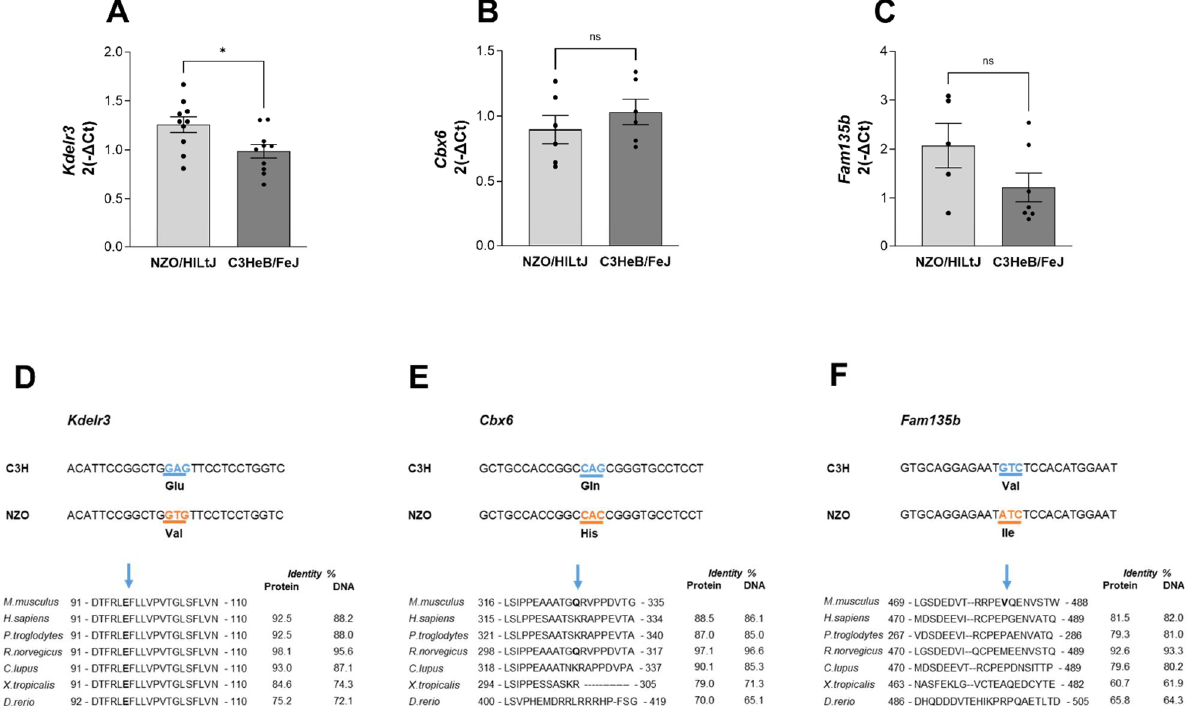
Figure 5. Combined approaches successfully identified potential causative genes underlying the Nbg15dis sublocus . Identification of C3H polymorphic regions underlying the Nbg15 sub-loci ( A ), variant effect prediction analysis (VEP) of identified non-IBD SNPs ( B ) and heatmap of islet specific genes containing non-IBD SNPs predicted to affect protein effectiveness selected via the VEP anal- ysis and the SIFT code under 0.5. Polymorphic regions were calculated using Genome Reference Consortium Mouse Build 38 provided by the Wellcome Trust Sanger Institute and defined as more than 50 SNPs/150 Kb window (gray boxes in ( A )). Red arrows ( A ) indicate the QTL peak markers of each Nbg15 sub-loci. VEP analysis is a free available tools from Ensembl and uses SnpEff (Open Source tool) tool to calculate subjective changes in proteins containing the SNPs or amino acid exchanges. SIFT (Sorting Intolerant from Tolerant) is an additional VEP score that consider physical properties of amino acid exchanges to determine its protein impact. Microarray expression of mouse parental VEP and SIFT sorted genes were used to generate the heatmap for pancreatic islet specific expressed genes. The ratio of islet expression vs. liver, muscle (quadriceps), gWAT (gonadal white adipose tissue) and BAT (brown adipose tissue) was calculated as Z-Score for the NZO, C3H and B6 mouse strains. Genes with high scores observed for all mouse strains and tissues were considered as main candidates for the Nbg15 locus ( C ).